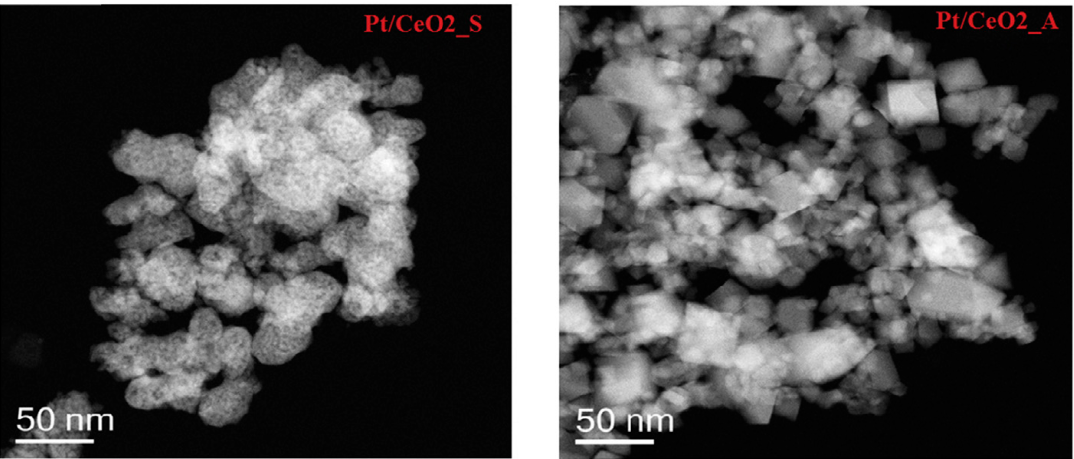
Figure 2. TEM images of Pt / CeO 2 _S and Pt / CeO 2 _A samples, reproduced from [26], with permission from Elsevier, 2018.